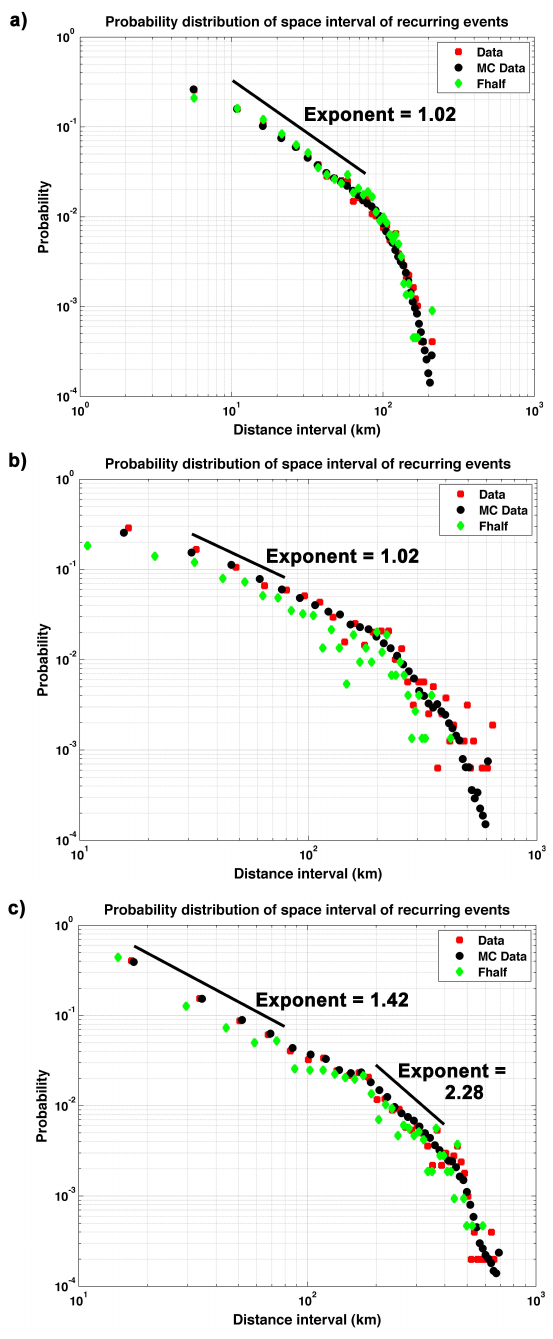
Fig. 10. Distribution of distance-intervals of recurrent events for the data and the recent half of the data. MC1 results are shown, as well. (a) Region 1; (b) Region 2; (c) Region 3.